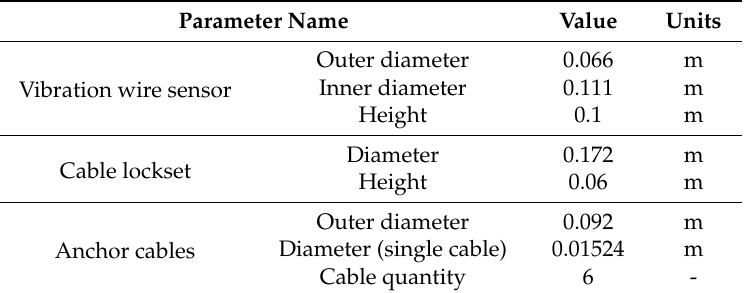
Table 2. Geometric parameters of the vibrating wire sensor, the cable locket, and the anchor cables.